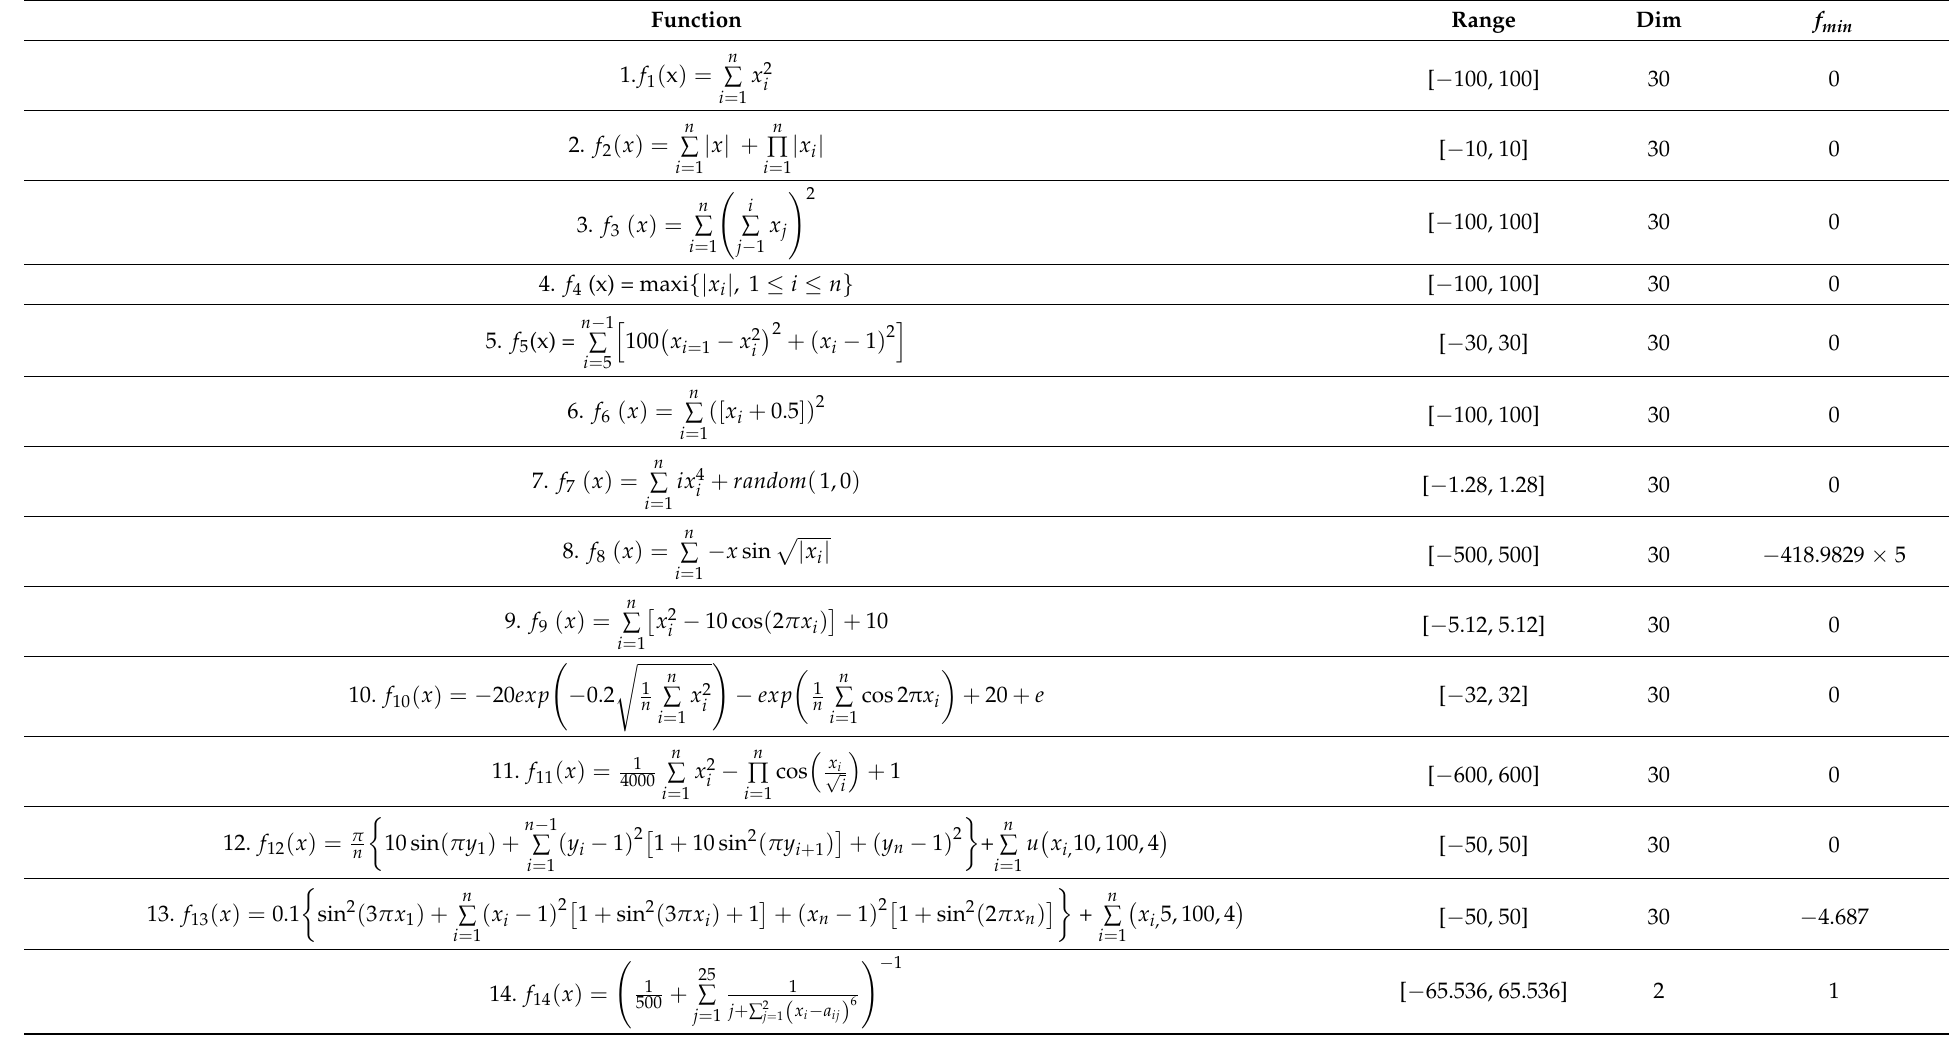
Table A1. Benchmark functions considered in the numerical